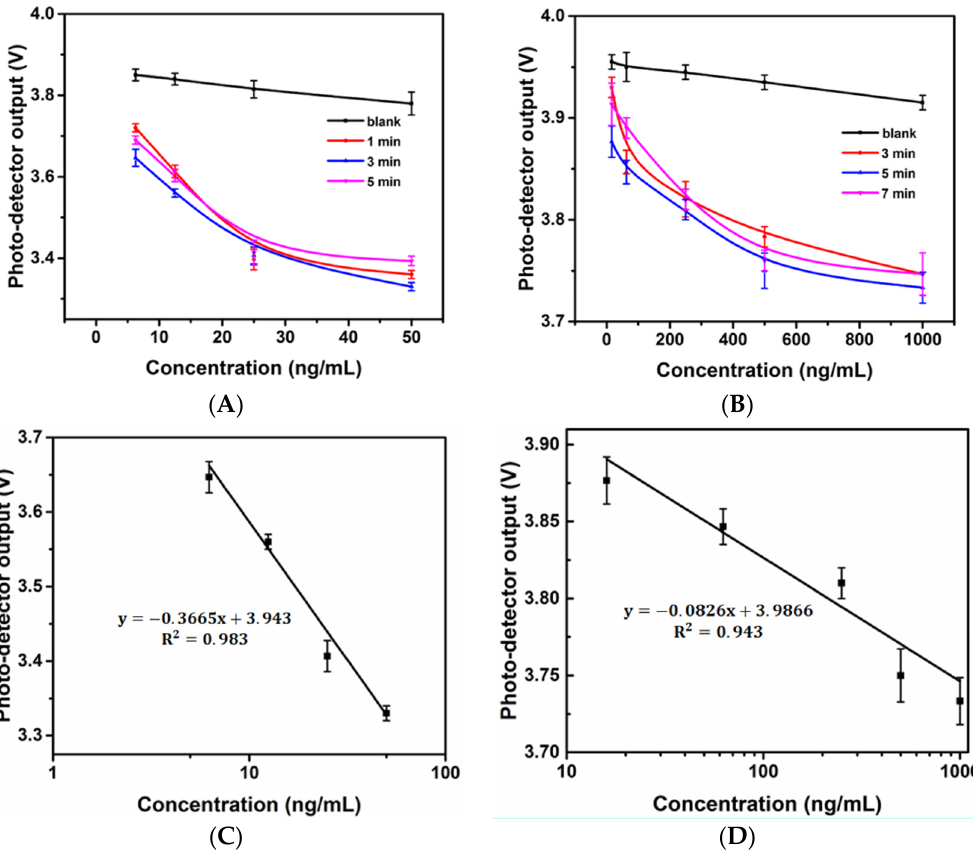
Figure 3. Time-dependent response of the developed optical microfluidic biosensor upon sensing the gluten standard solution ( A ) and Ara h 1 standard solution ( B ); Linear standard curves of gluten ( C ) and Ara h 1 ( D ).